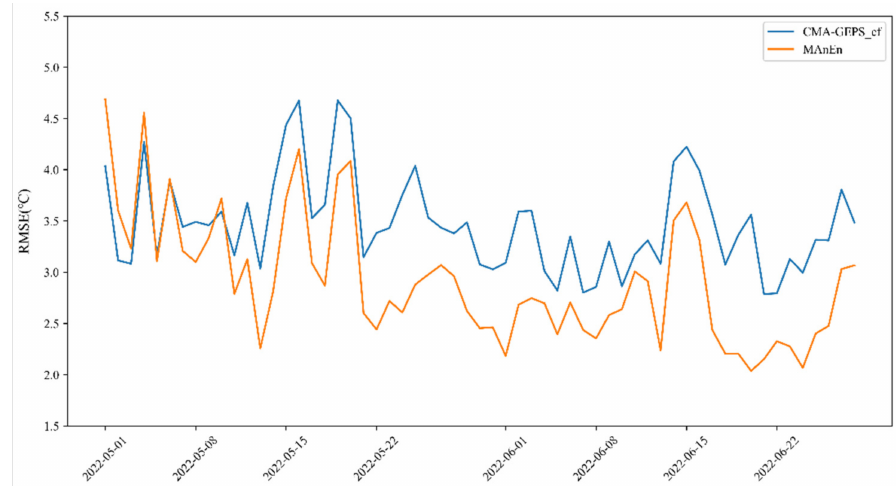
Figure 5. RMSE of daily 240 h forecast for 1 May–28 June 2022.